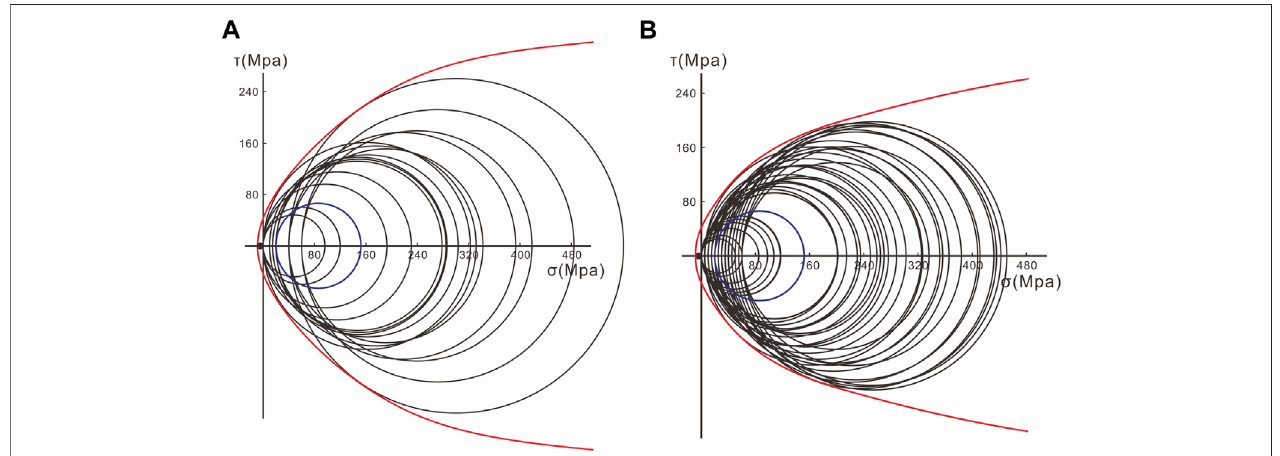
FIGURE 12 | Mohr envelope curves in the Yuanba Gas Field. (A) Dolomite of the Changxing Formation; (B) limestone of the Feixianguan Formation.